Question: Provide a one-line summary of what is displayed.
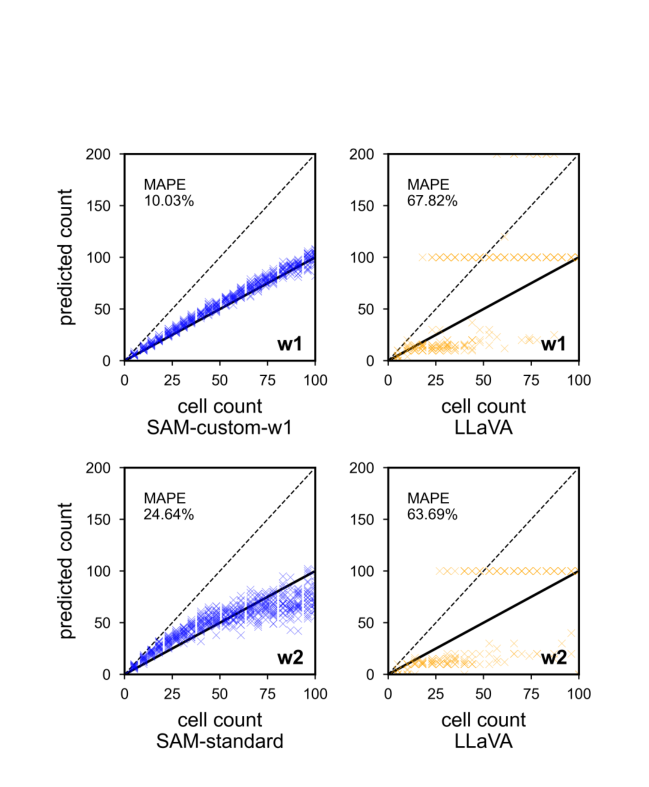
Answer: Predicted cell counts for the 1200 image subset of the BBBC005 dataset plotted against the actual counts, for LLaVA and SAM. Counts by SAM on w1 subset are shown for SAM-custom-w1 parameters, while counts on w2 dataset are shown for SAM-standard parameters, both best performing parameters for counting task. Mean absolute percent error (MAPE) is included for quantitative comparison.